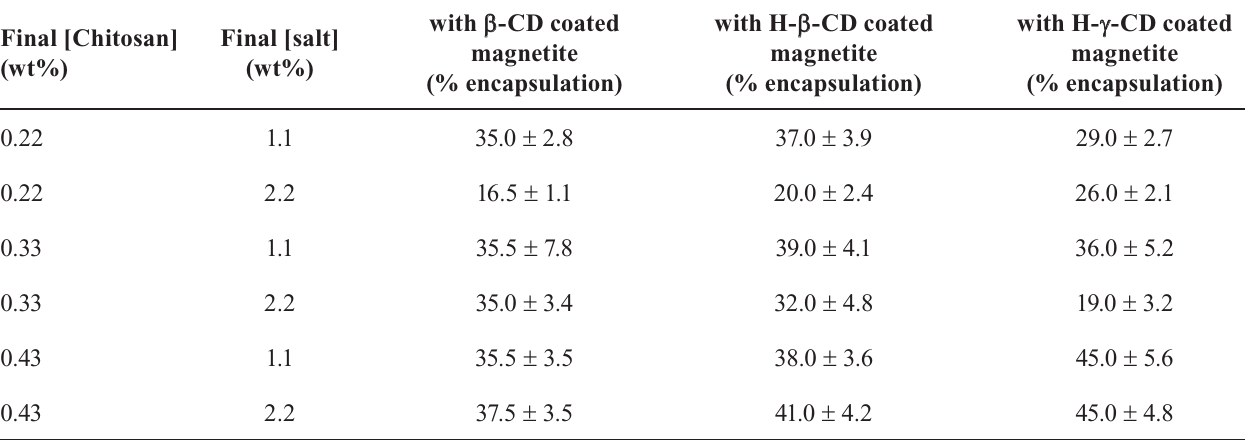
TABLE II - % Encapsulated TMZ in magnetite-chitosan nanobeads comparing chitosan and salt concentrations